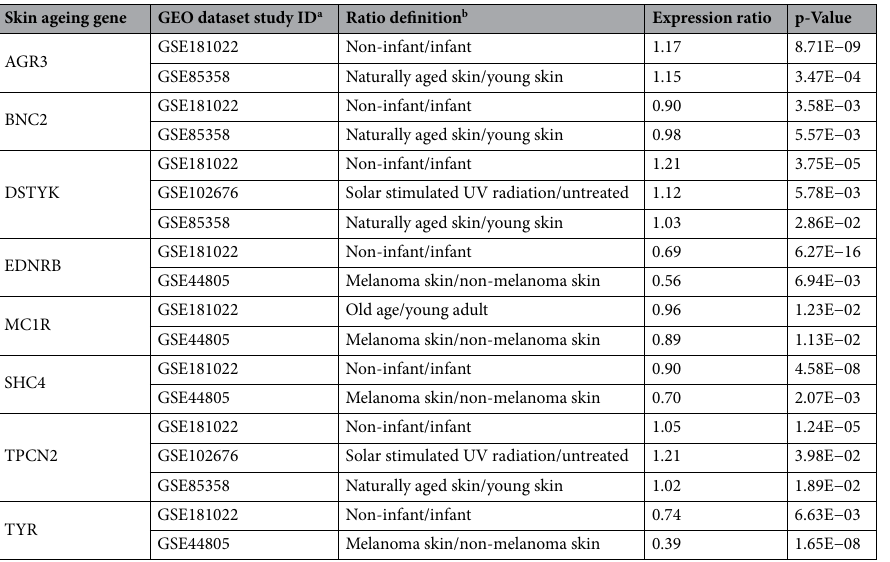
Table 4. Differentially expressed skin colour genes associated with chronological age. a GSE181022 controls for sun exposure by using only sun-protected skin. The skin tissue in GSE85358 is skin aged normally, which will typically be exposed concurrently to numerous factors (e.g., chronological age and sun exposure). b The expression ratio is the average expression level in the aged tissue or tissue with skin ageing phenotypes (i.e., cases) divided by (/) the average expression level in the young tissue or tissue without skin ageing phenotypes (i.e., reference). Ratios above 1 indicate higher expression levels in the cases group while ratios below 1 indicate lower expression levels in the cases group.